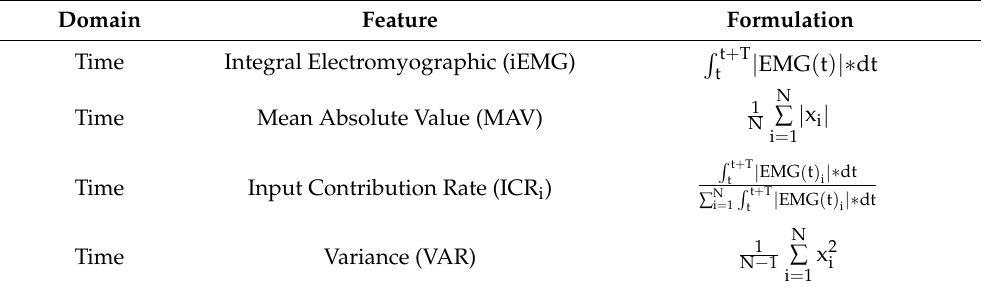
Table 1. Table 1. Time features extracted from the EMG